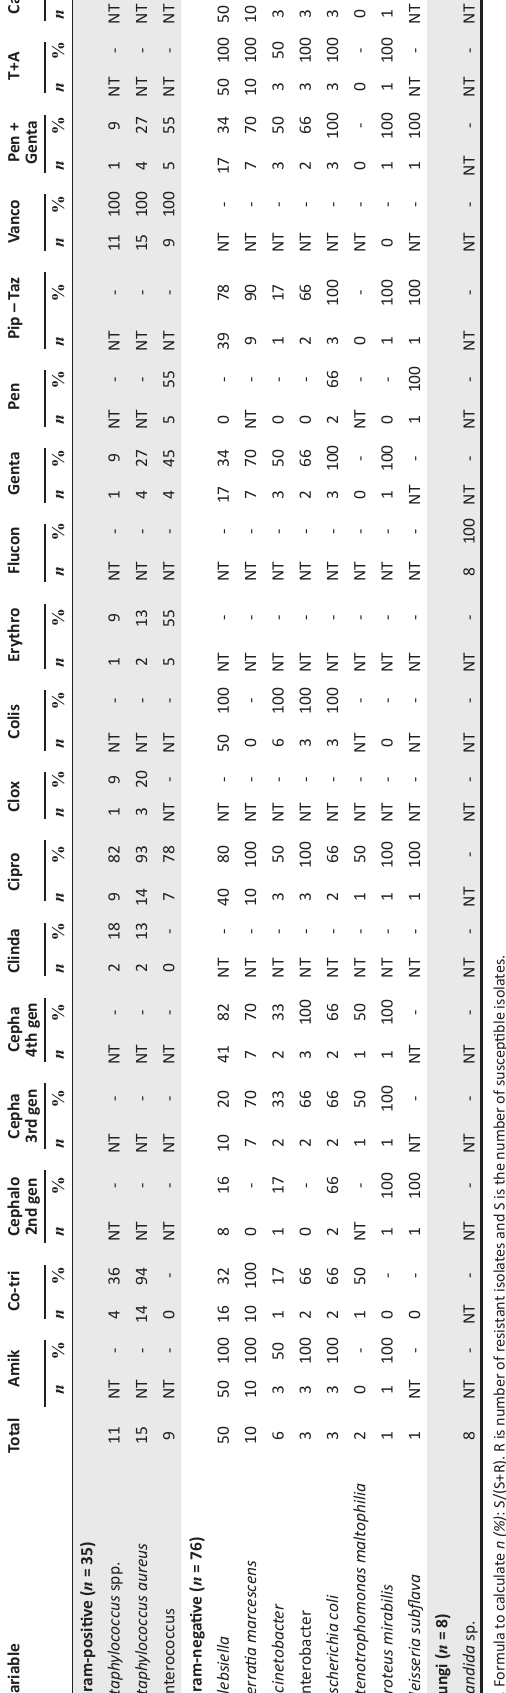
TABLE 2: Early onset versus late onset sepsis. Organism subtype n